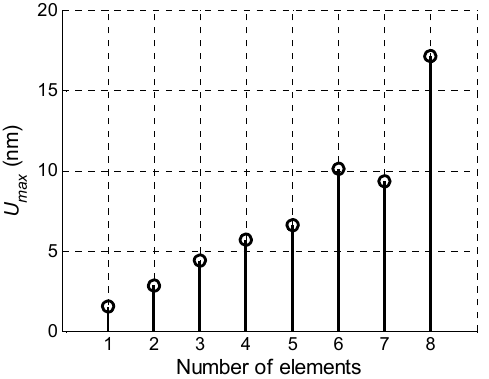
Figure 30. Maximal amplitudes of the normal displacement signal U max of the PVC film, measured at L = 1 mm versus number of the excited array elements in the case of the optimised delay times.